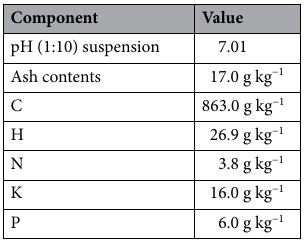
Table 2. Characterization of timber waste